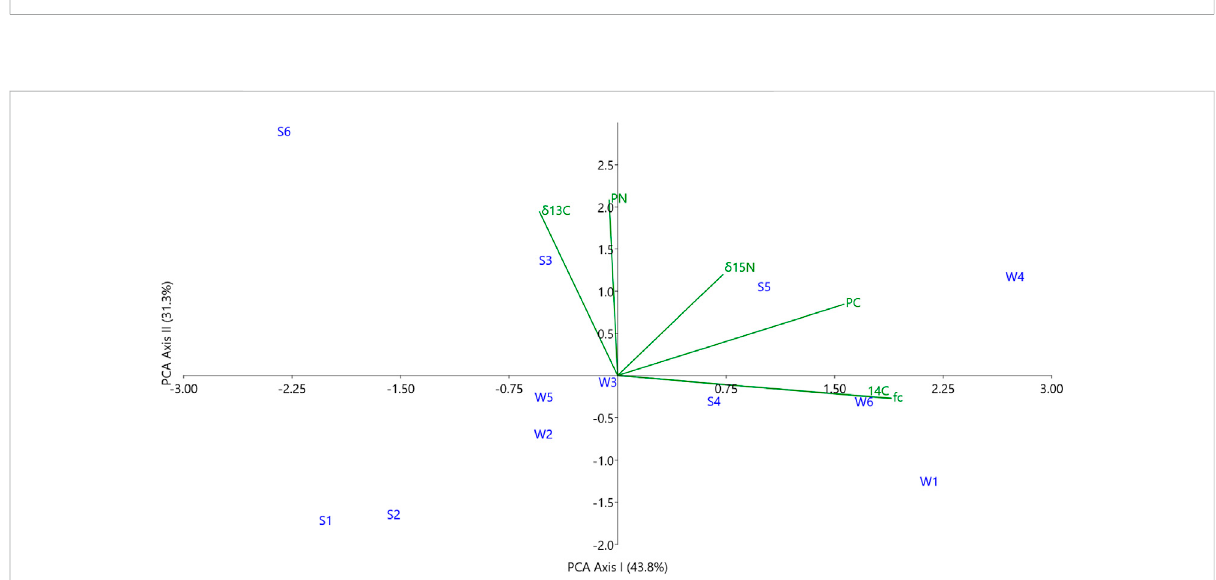
FIGURE 5 Two-dimensional Principal Component Analysis (PCA) for the 6 winter (W) and 6 spring-summer (S) samples. The input variables are the stable isotope measurements of nitrogen and carbon ( δ 15 N and δ 13 C, respectively), particulate nitrogen and carbon content (PN and PC, respectively), amount of 14 C expressed in a unit of percent modern carbon (pMC), and the contemporary carbon fraction f c (%). The percentages of the total variance explained by the fi rst and second principal component are also indicated in the